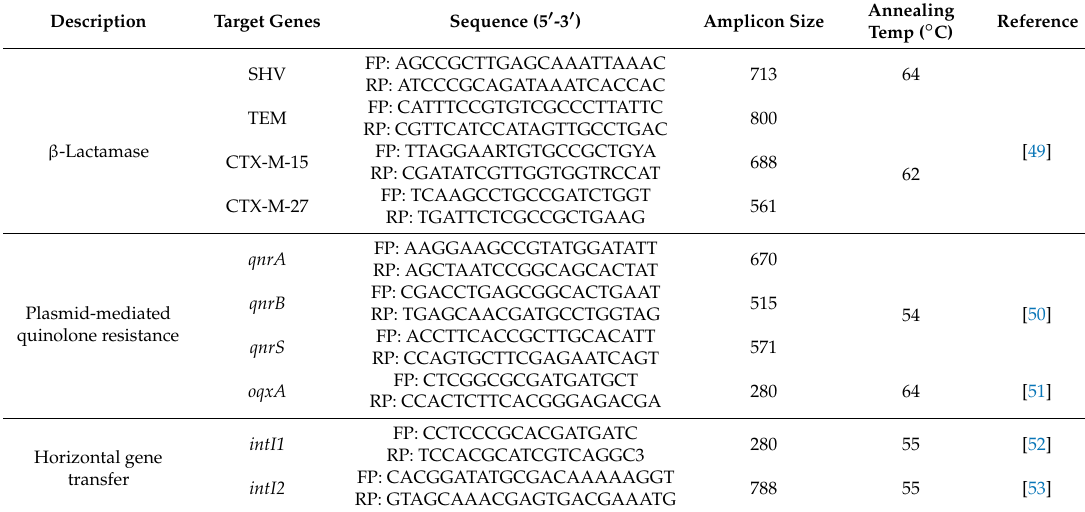
Table 1. Sequences of primers, PCR conditions, annealing temperature for amplifying target